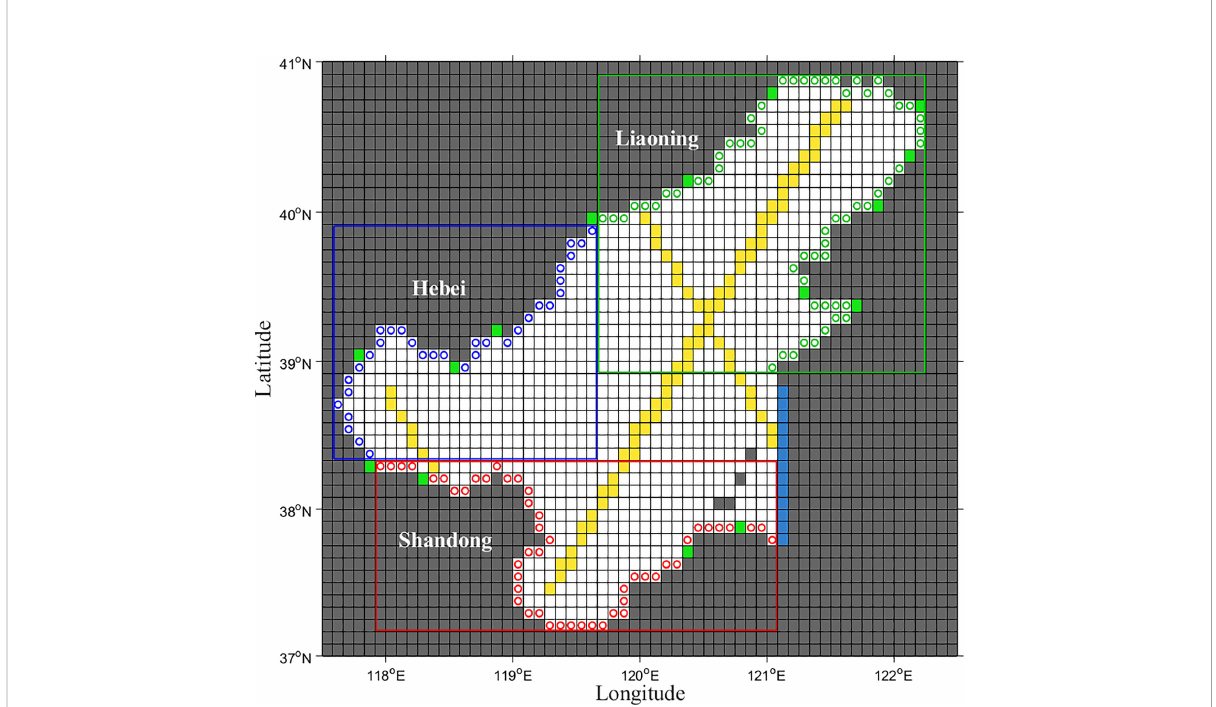
FIGURE 2 Grid map of different subdomains (circles with different colors represent coastline grids of different subdomains, the green grids represent existing tidal stations, the yellow grids represent TP-Jason altimeter tracks, the gray grids represent dry grid, and the white represents wet